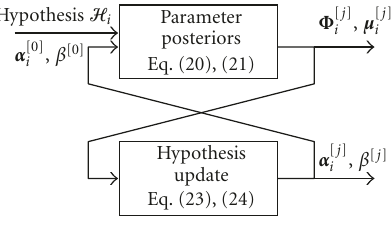
Figure 4: Iterative learning of the parameters; the superscript [ j ] denotes the iteration index.